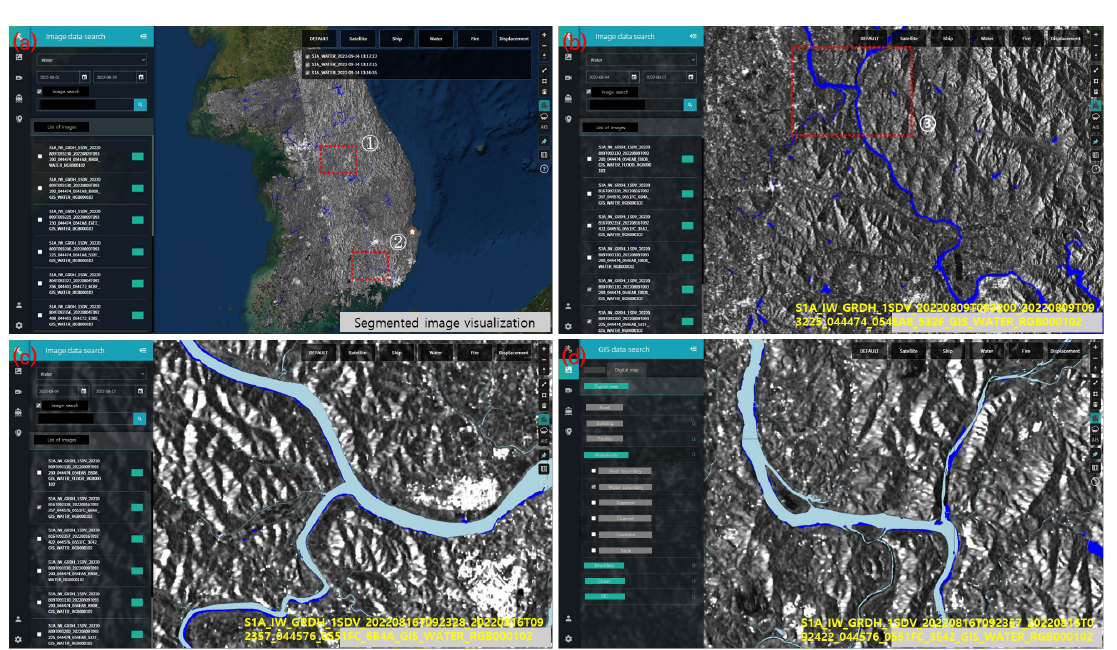
Figure 11. Visualization and spatial analysis of output images: ( a ) visualization of fully automated flood monitoring for the 2022 flood event, ( b ) enlarged image of 1 (cid:13) in ( a )—automatically extracted waterbodies; ( c ) enlarged image of 2 (cid:13) in ( a )—river boundaries from digital maps (sky blue) overlaid on extracted waterbodies; ( d ) enlarged image of 3 (cid:13) —blue color shows flooded